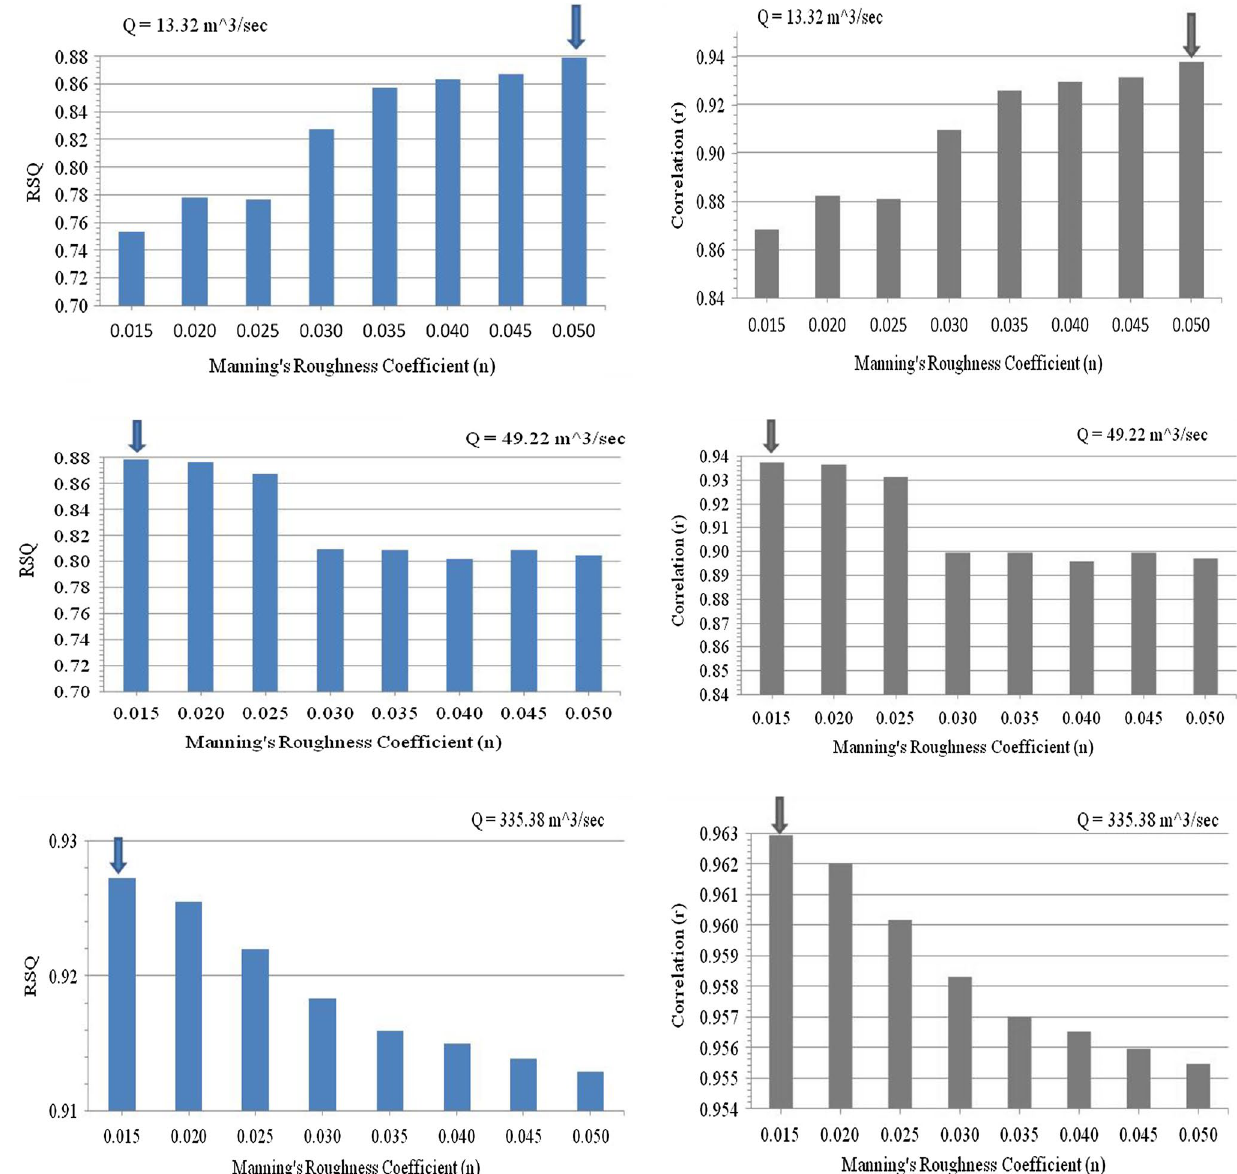
Fig. 5 The performance of the CCHE2D model for different Manning’s roughness